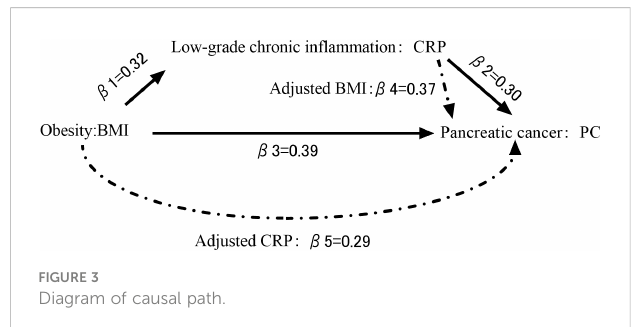
FIGURE 3 Diagram of causal path.